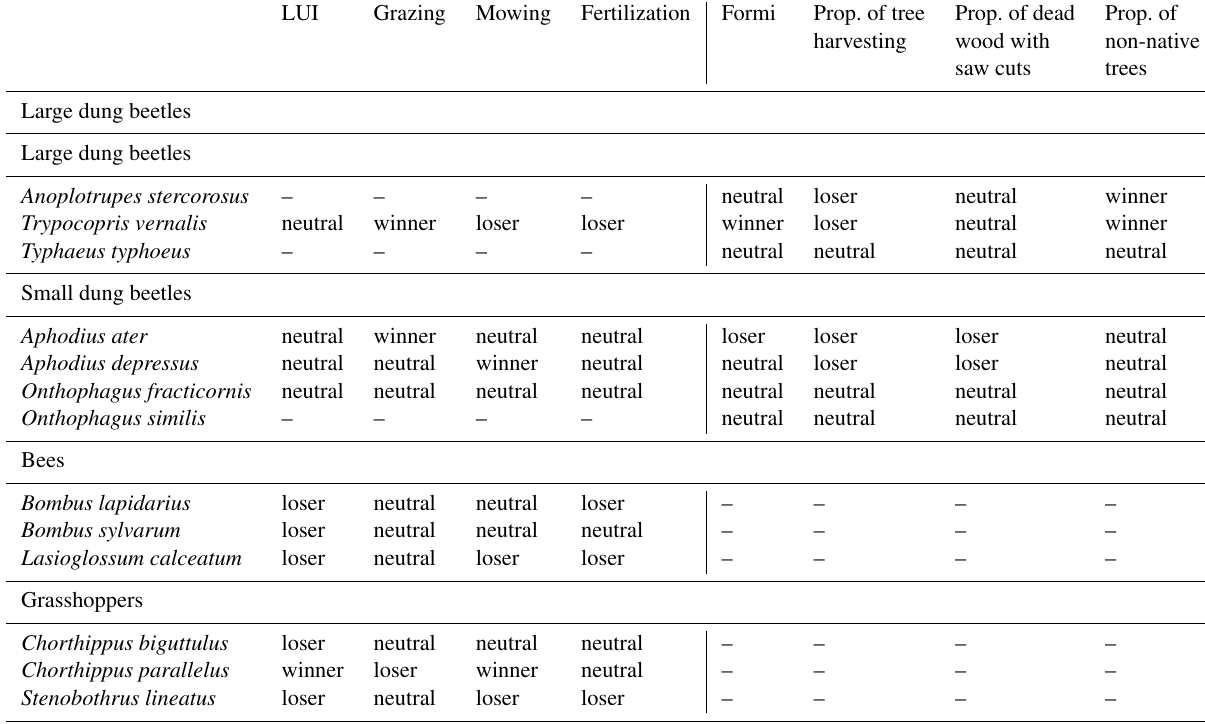
Table 1. Species overview and their “winner”/“loser” status to land-use intensity. LUI Grazing Mowing Fertilization Formi Prop. of tree Prop. of dead Prop. of